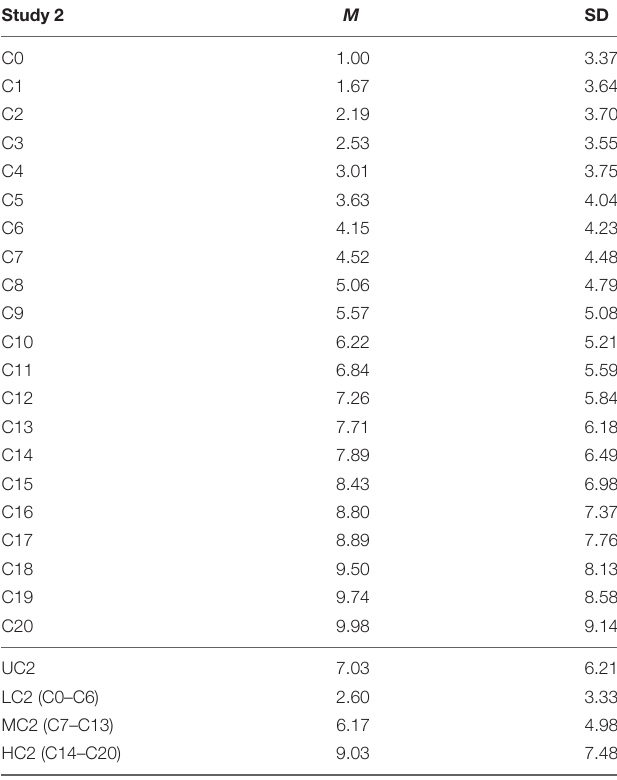
TABLE 4 | Mean contributions in Study